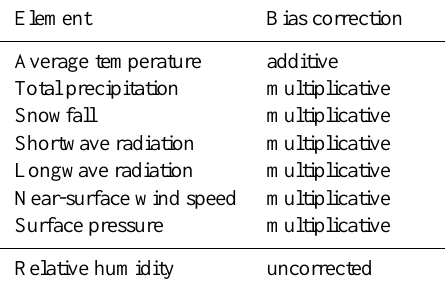
Table 1. Bias-corrected meteorological data used in this study. The data sets were distributed by the ISI-MIP, after bias correction by the method proposed by Hempel et al.